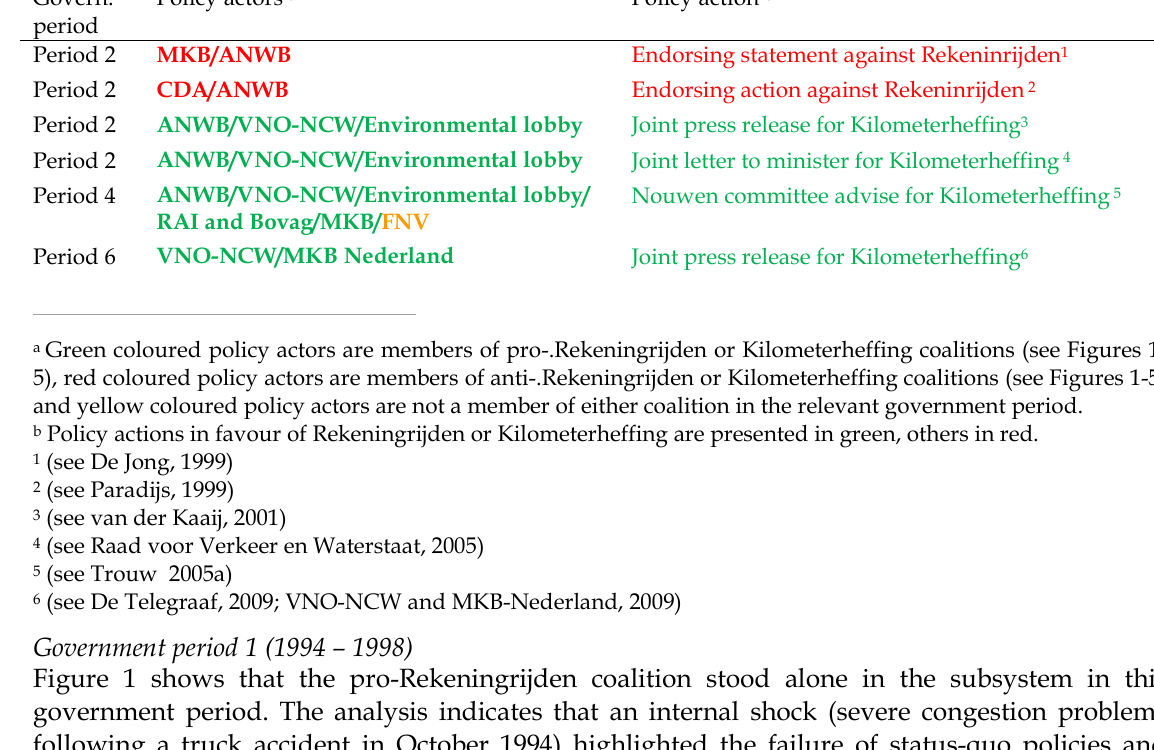
Table 4. Endorsing statement/actions and joint statements